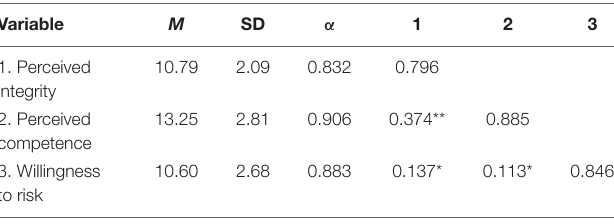
TABLE 1 | Study 1 means, standard deviations, reliabilities, and intercorrelations.